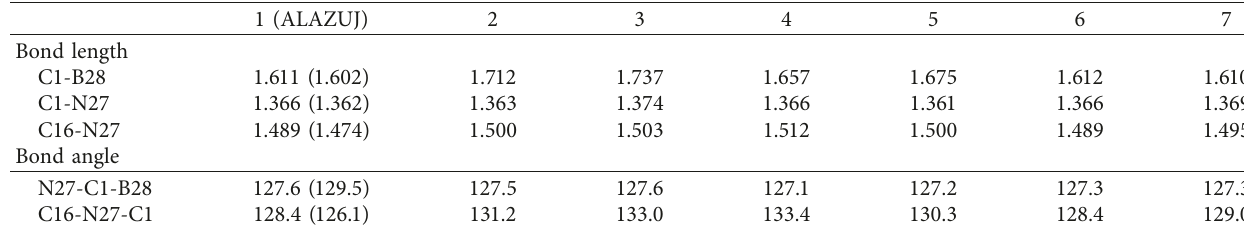
Table 4: Selected bond lengths (˚A) and bond angles ( ° ) of the optimized borane complexes with the experimental reference in parenthesis.